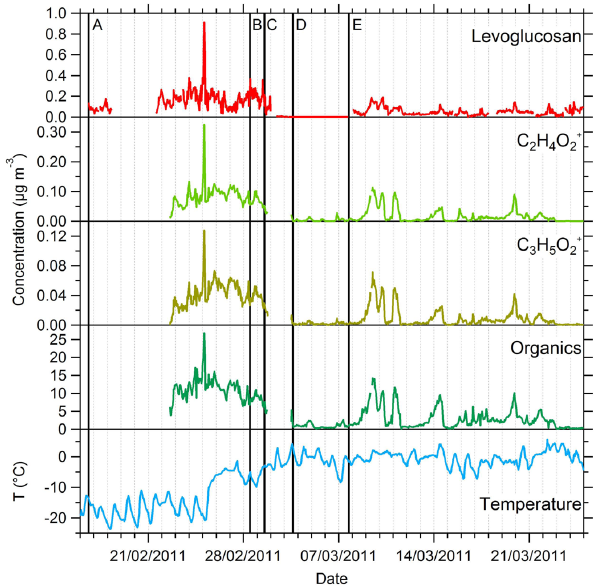
Fig. 6. Online measured levoglucosan (PILS–HPAEC–MS) com- pared with the time series of C 2 H 4 O + and C 3 H 5 O + fragments and 2 2 the sum of organics (HR-ToF-AMS) with the air temperature. All measured values are averaged with 1h time resolution. The letters A–E as in Fig.